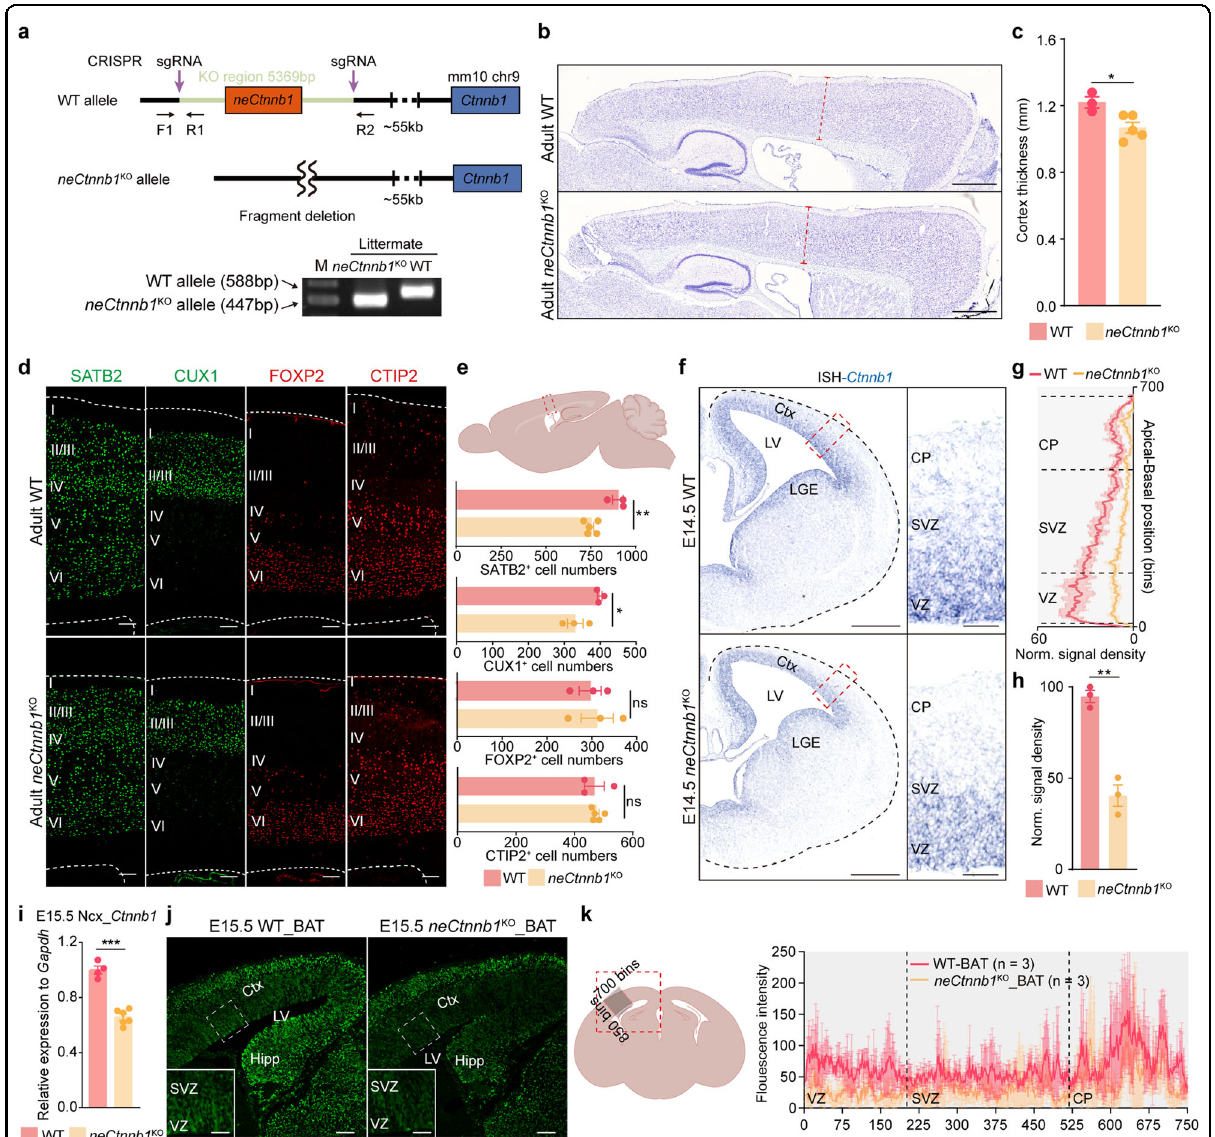
Fig. 2 Knock-out of neCtnnb1 in mice inhibits the production of upper-layer PNs and Ctnnb1 transcription. a Generation and genotyping of neCtnnb1 KO mice. WT, wild-type; gRNA, guide RNA. b Nissl-staining on adult WT and neCtnnb1 KO sagittal brain sections. c Comparison of neocortical thickness of adult WT and neCtnnb1 KO mice. n = 3 for WT brains and n = 5 for neCtnnb1 KO brains. Each point represents an individual brain. d , e Immuno fl uorescence ( d ) and quanti fi cation ( e , top) of SATB2 + , CUX1 + , FOXP2 + and CTIP2 + neurons on boxed area of sagittal sections ( e ) of adult WT and neCtnnb1 KO Ncx. Each point represents an individual brain. f In situ hybridization (ISH) of Ctnnb1 on E14.5 WT (top) and neCtnnb1 KO (bottom) coronal brain sections, with boxed regions magni fi ed on the right. g , h Quanti fi cation of normalized ISH signal densities in boxed regions of ( f ). n = 3 for WT brains and n = 3 for neCtnnb1 KO brains. Each point represents an individual brain. i RT-qPCR showing expressions of Ctnnb1 in E15.5 WT and neCtnnb1 KO neocortex. n = 4 for WT Ncx and n = 6 for neCtnnb1 KO Ncx. Each point represents an individual brain. j β -Gal immunostaining on the E15.5 coronal sections of WT_BAT (left) and neCtnnb1 KO _BAT (right) Ncx. Boxed regions are enlarged at the bottom left corners. k Quanti fi cation of normalized signal density of β -Gal in boxed regions of ( j ). n = 3 for WT brains and n = 3 for neCtnnb1 KO brains. Each point represents an individual brain. Quanti fi cation data are shown as means ± SEM. Statistical signi fi cance was determined using an unpaired two-tailed Student ’ s t -test ( c , e , h and i ). *P < 0.05, **P < 0.01, and ***P < 0.001. ns, not signi fi cant. Scale bars, 500 μ m ( f ), 200 μ m ( b ), 100 μ m ( d and j ), 50 μ m (magni fi ed views in f and j ). CP, cortical plate; VZ, ventricular zone; SVZ, subventricular zone; Ctx, cortex; LV, lateral ventricular; LGE, lateral ganglionic eminences; Hipp, Hippocampal